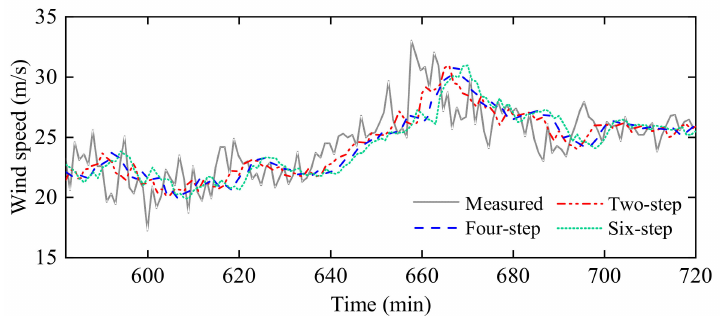
Figure 10. Multi-step ahead forecasted wind speeds by the ARIMA